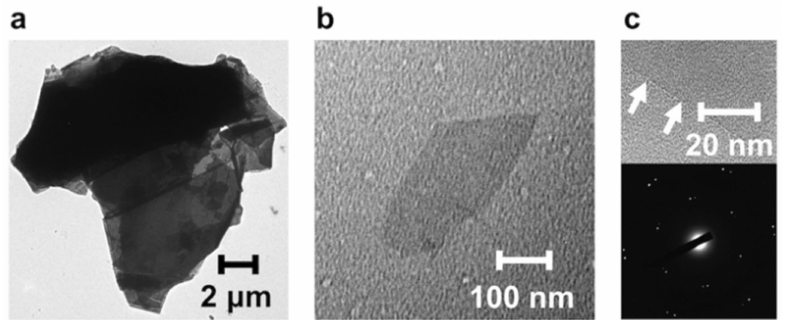
Figure 4. ( a ) TEM image of pristine graphite. ( b ) TEM image of a graphene sheet exfoliated using PImQ. ( c ) HR-TEM image and electron diffraction pattern for the edge of an exfoliated graphene sheet. Arrows indicate the edges of exfoliated graphene